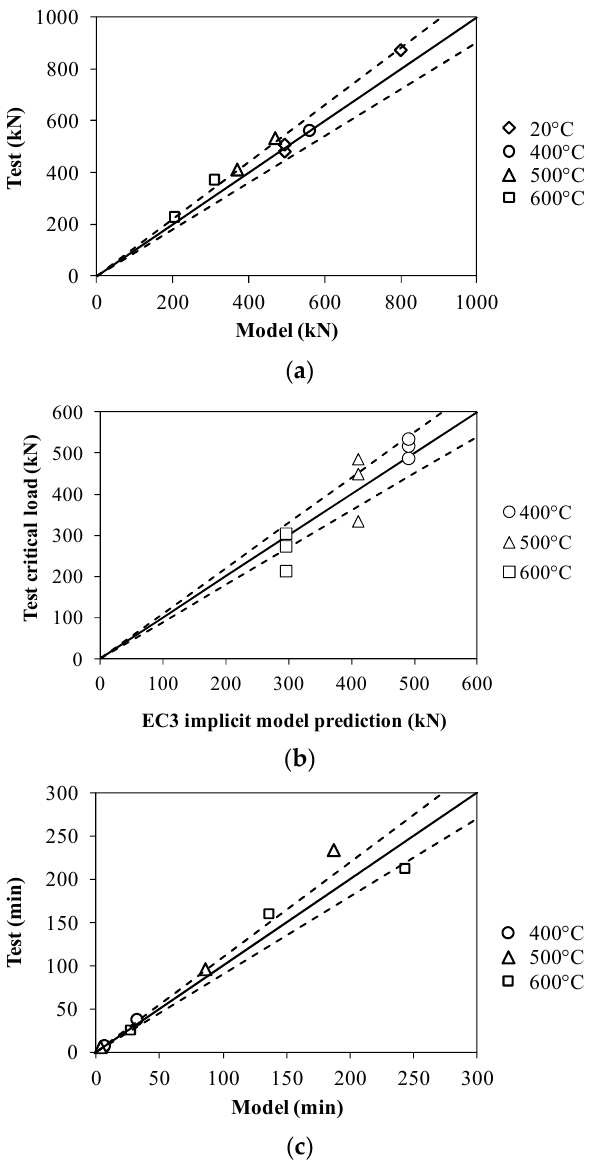
Figure 9. Accuracy of the numerical study: ( a ) capacity tests: comparison with creep-free EC3 model analysis; ( b ) creep tests: comparison with EC3 “implicit creep” model analysis; and ( c ) creep tests: comparison with explicit creep model analysis.